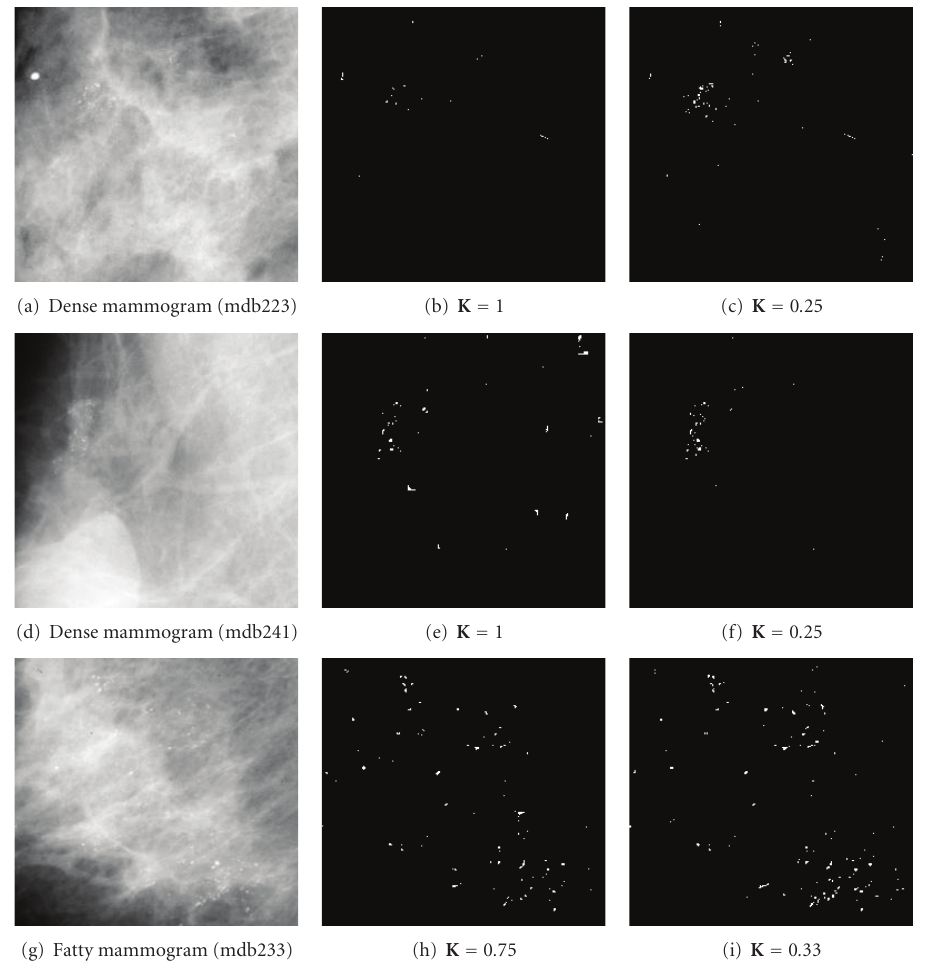
Figure 12: Examples of the detection results using di ff erent K